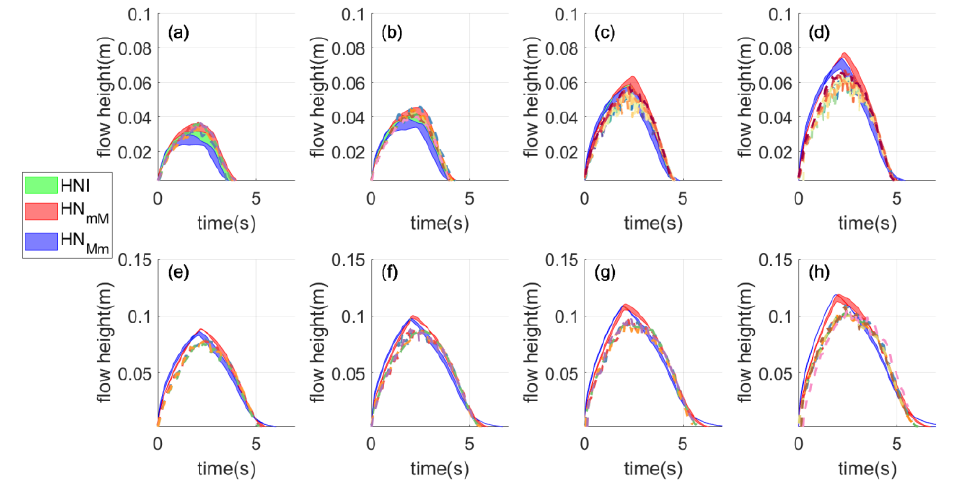
Figure 5. Flow height profiles at position P2; ( a – h ) refer to different basin water levels; h 0 = 0.15, 0.16, 0.18, 0.20, 0.22, 0.24, 0.26, 0.28 m. Dash lines are the experimental data.